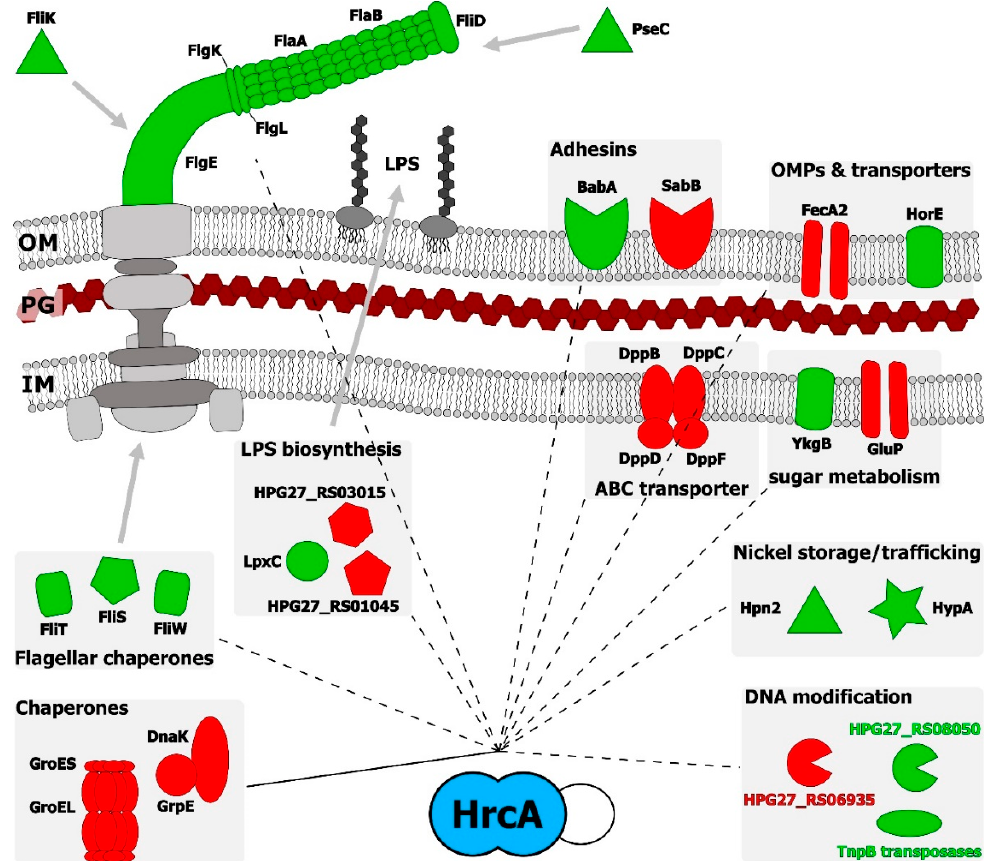
Figure 4. The network connects HrcA to the regulated target proteins. Filled lines indicate verified direct regulation, while dashed lines depict uncertain direct or indirect connections (not experimentally verified). HrcA-mediated positive or negative effects on genes’ expression are represented in green and red, respectively. HPG27_RS03705, HPG27_RS04725 and genes coding for hypothetical protein with unknown function have not been included in the network representation. Symbols are as follows: IM: Inner membrane; PG: Peptidoglycan layer; outer membrane; LPS: Lipopolysaccharide.